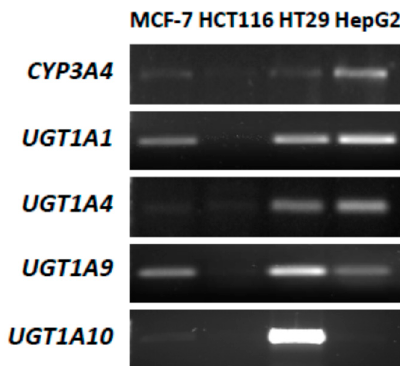
Figure 2. Reverse transcription-polymerase chain reaction (RT-PCR) analysis of mRNA expression of P4503A4 isoenzyme and selected UDP-glucuronosyltranspherase (UGT) isoenzymes: 1A1, 1A4, 1A9 and 1A10 in control, untreated MCF-7, HCT116, HT29 and HepG2 cells.